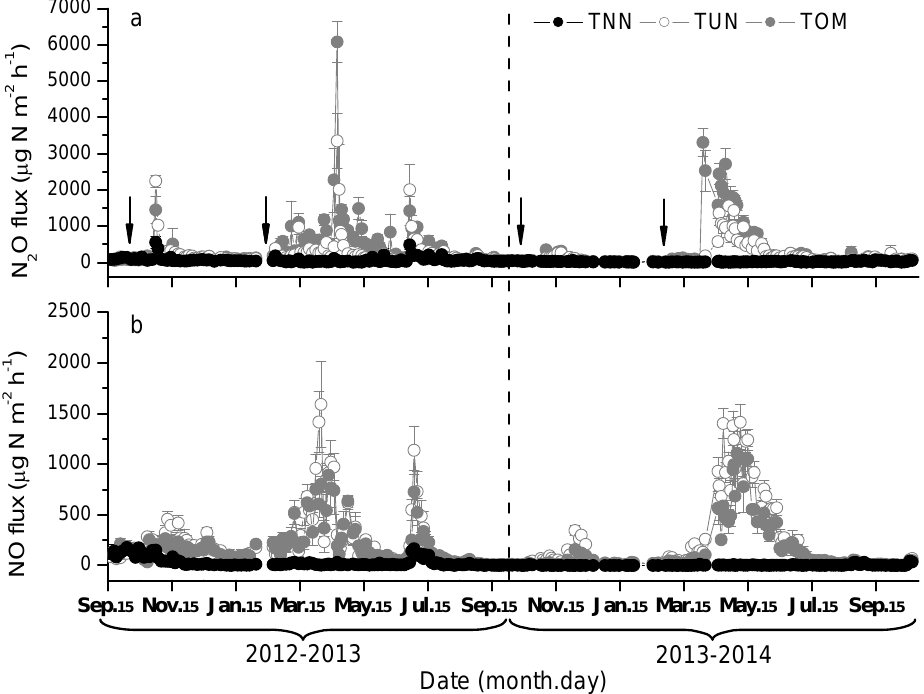
Figure 3. Seasonal changes of (a) nitrous oxide (N 2 O), and (b) nitric oxide (NO) fluxes (mean ± standard error) for all the fertilizer treatments ((i.e., the common practice with urea application (TUN), the alternative practice with organic fertilizer application (TOM), and no nitrogen fertilizer application (TNN)) in tea plantations during the period from September 2012 to October 2014. The downward arrows denote the time of fertilization.